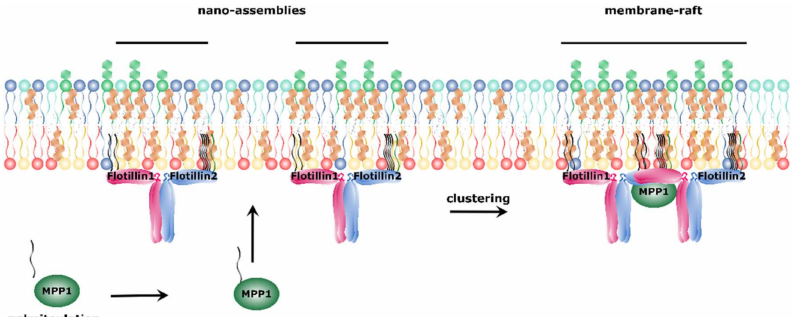
Figure 3. Proposed mechanism of functional membrane raft formation. Palmitoylated MPP1 binds to the flotillins present in cholesterol and sphingomyelin-enriched nano-assemblies. This binding initiates oligomerization of flotillins and coalescence of nano-assemblies into membrane